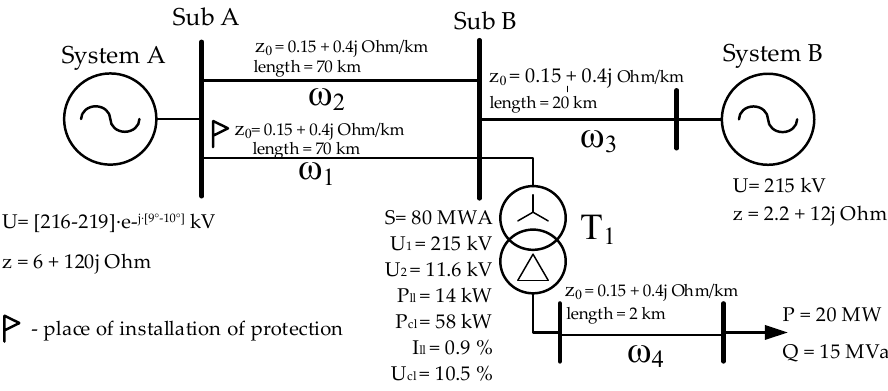
Figure 14. Calculation scheme of the electric network section.